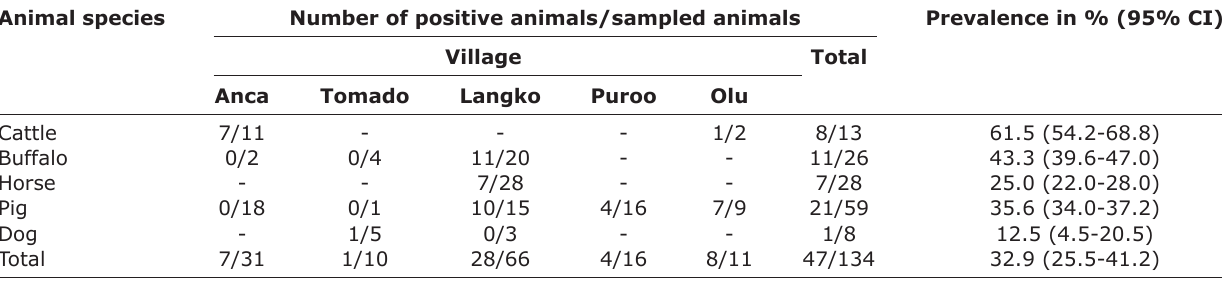
Table-1: Prevalence of S. japonicum infection in each species and village in the Lindu Subdistrict based on the Danish Bilharziasis Laboratory method. Animal species Number of positive animals/sampled